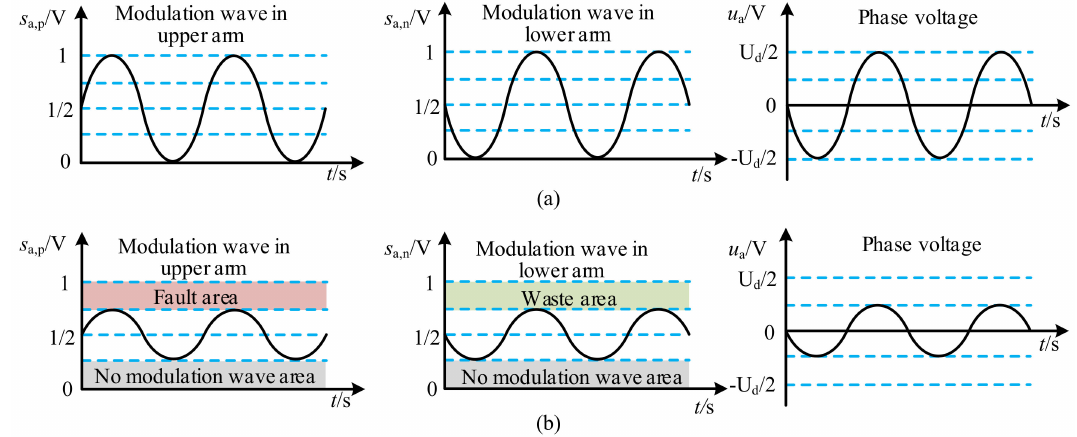
Figure 2. Diagram of MMC fault tolerance capability analysis. ( a ) Normal operation; ( b ) Fault